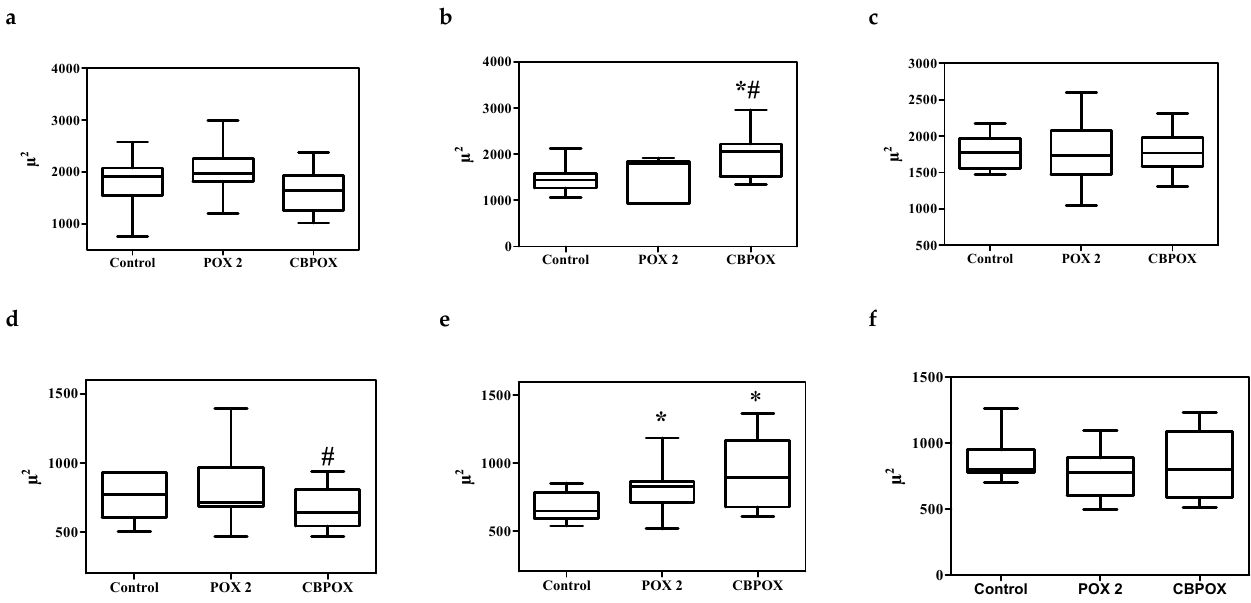
Figure 3. A ( a – c ). Renal corpuscle area, mm 2 : ( a ) 1 day, ( b ) 3 days, and ( c ) 7 days after exposure to POX. B ( d – f ). Renal glomerulus area, mm 2 : ( d ) 1 day, ( e ) 3 days, and ( f ) 7 days after the exposure. * p ≤ 0.01 compared to the control group; # p ≤ 0.01 between POX2x and CBPOX groups.